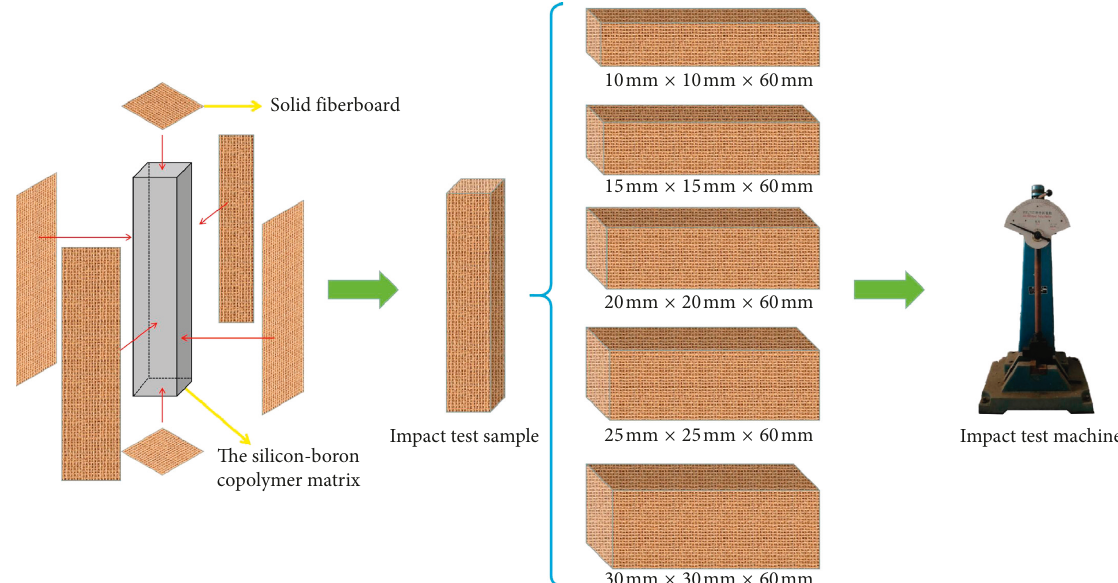
Figure 9: The preparation process of the test samples and the impact test